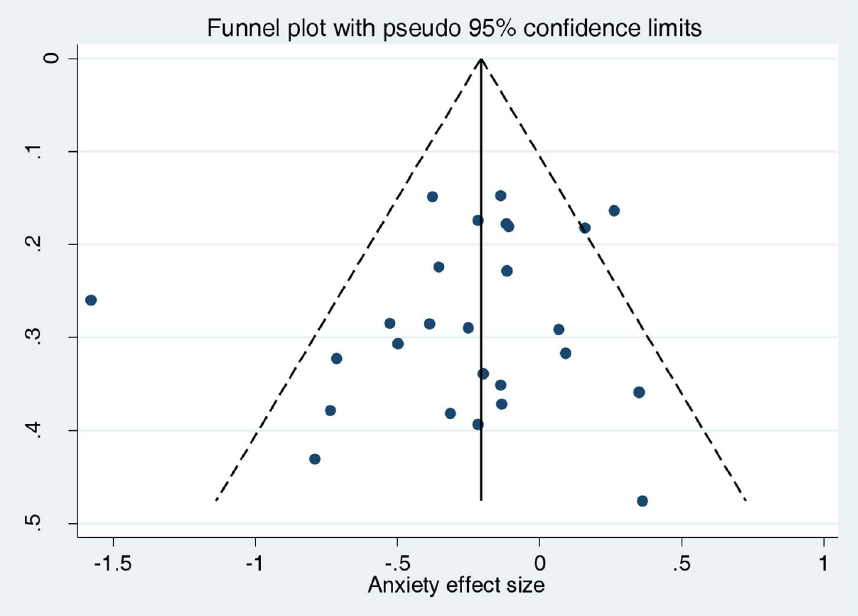
Figure 5. Funnel plot of effect size versus standard error for anxiety outcomes.